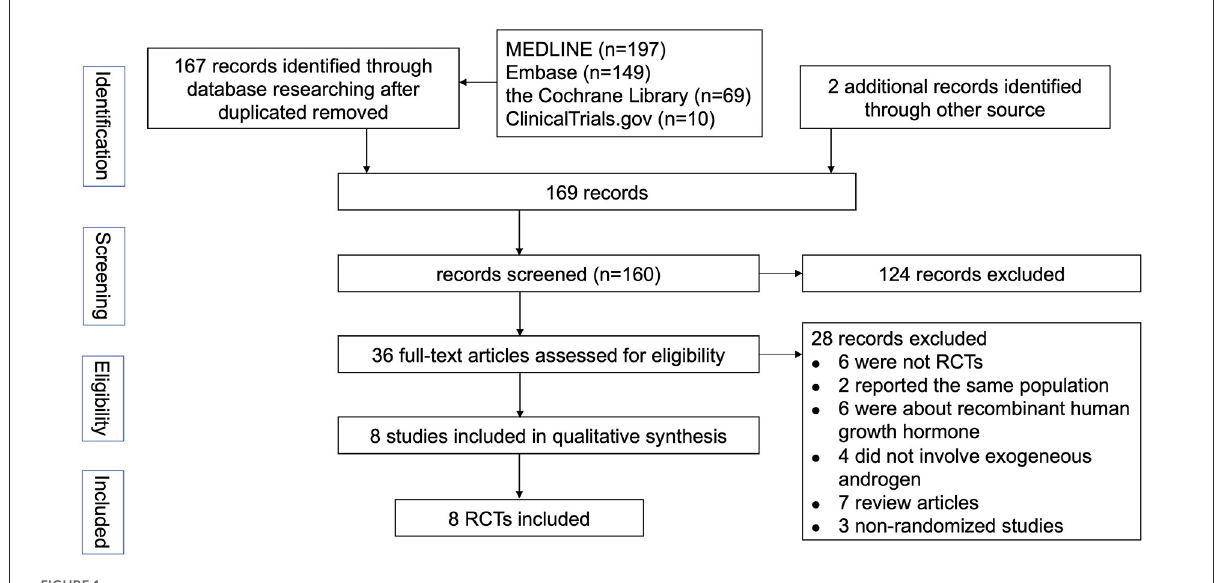
FIGURE1 Flow diagram for study selection. RCTs, randomized control